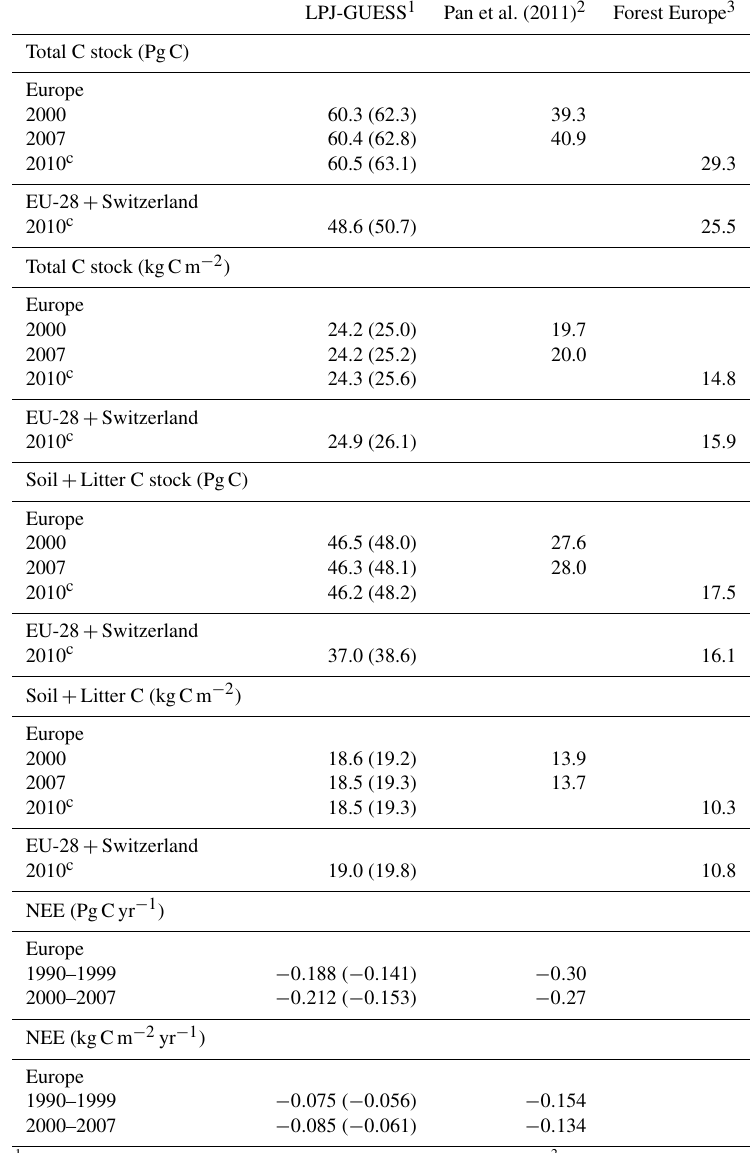
Table 3. Modelled and observed total carbon stock, soil plus litter carbon, and net ecosystem exchange (NEE) in European